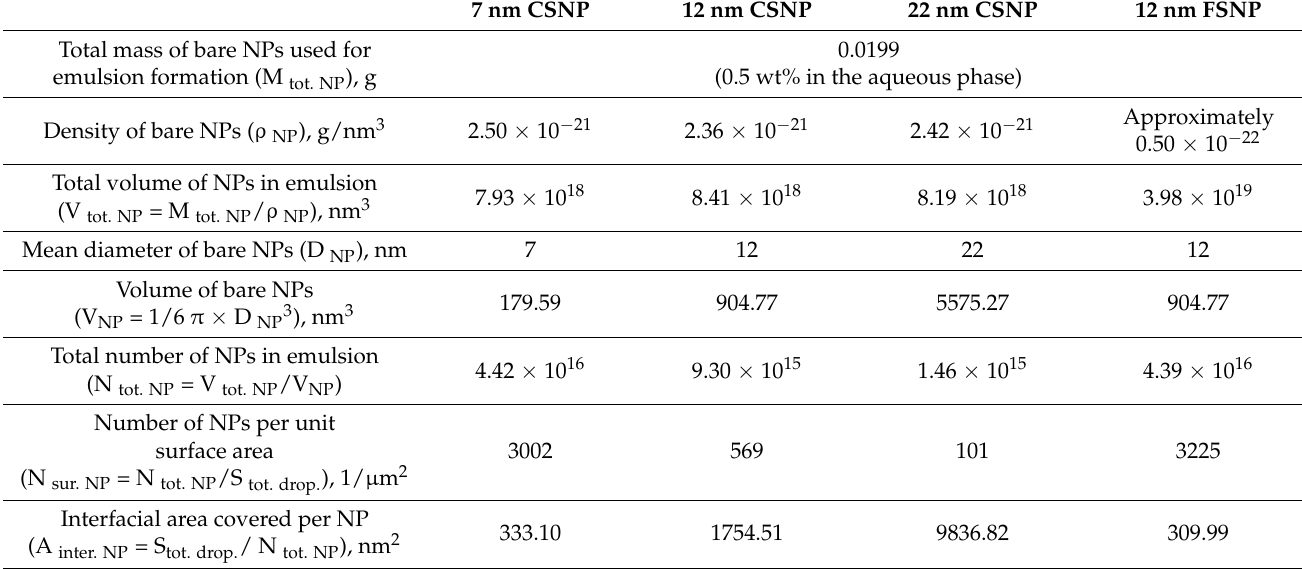
Table 2. Interfacial areas covered by single NPs.